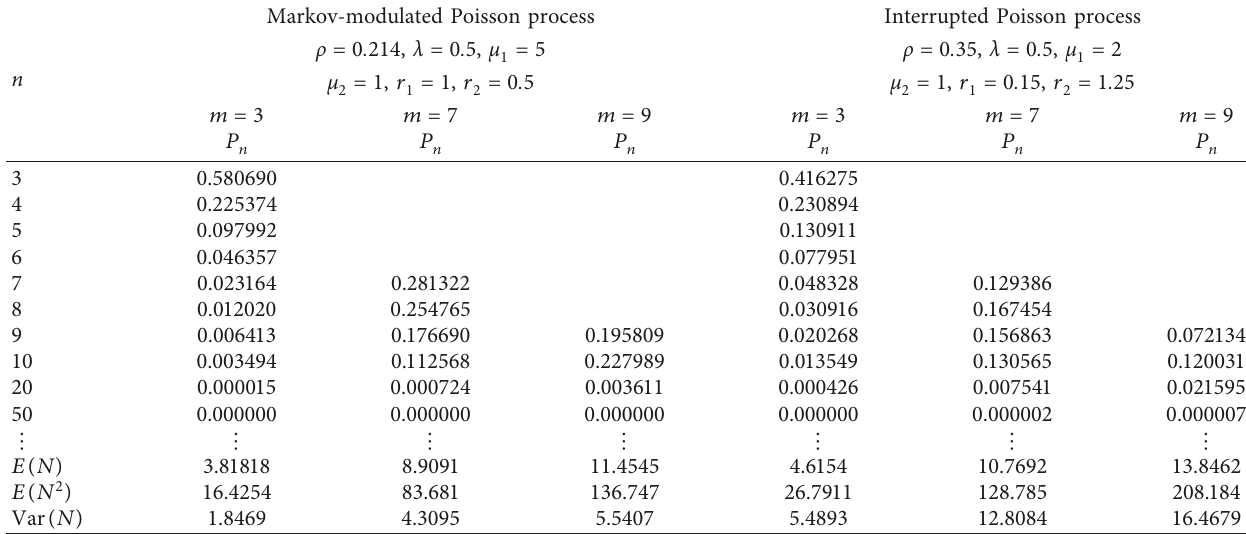
Table 5: Distribution of the number of customers served during a busy period.